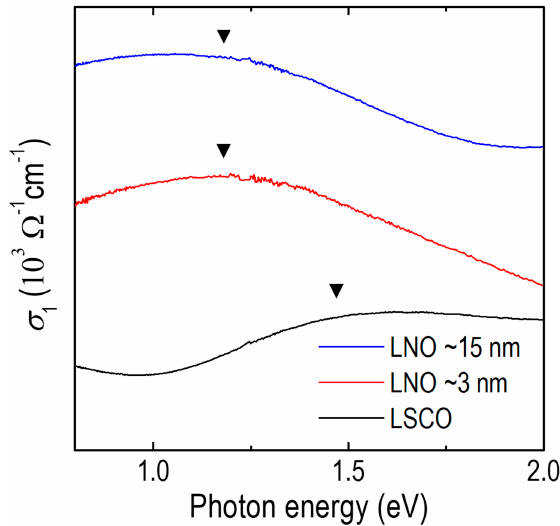
Figure 4. Optical conductivity ( σ 1 ) of the undecorated LSCO and LNO-decorated LSCO